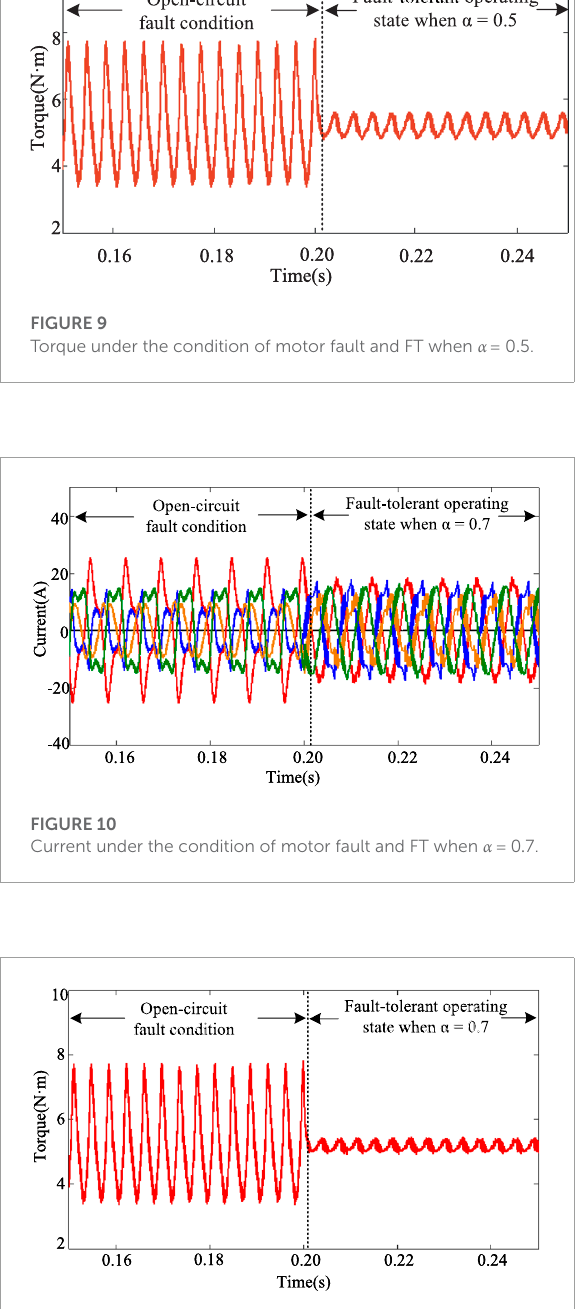
FIGURE 11 Torque under the condition of motor fault and FT when α = 0 . 7.